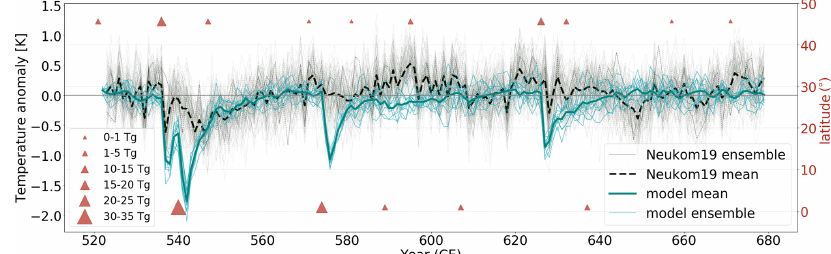
Figure A2. Model–proxy reconstruction comparison for the entire Northern Hemisphere with PAGES2k data (Neukom et al., 2019). Mean anomalies are calculated for the 1–1850CE reference period. The red triangles represent the volcanic eruptions from the model forcing (Toohey and Sigl, 2017) according to their latitude (tropical or NH extratropical), and the size of the triangle corresponds to the estimated range of sulfur [TgS] injected into the stratosphere.